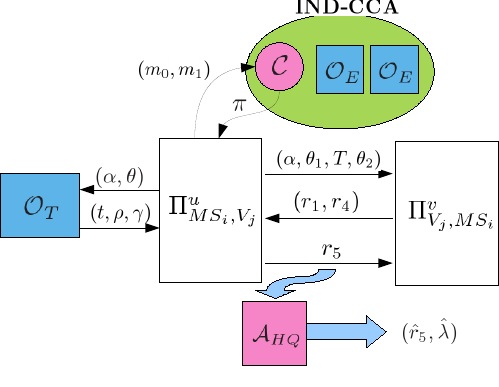
Figure A1. The proof model of Theorem